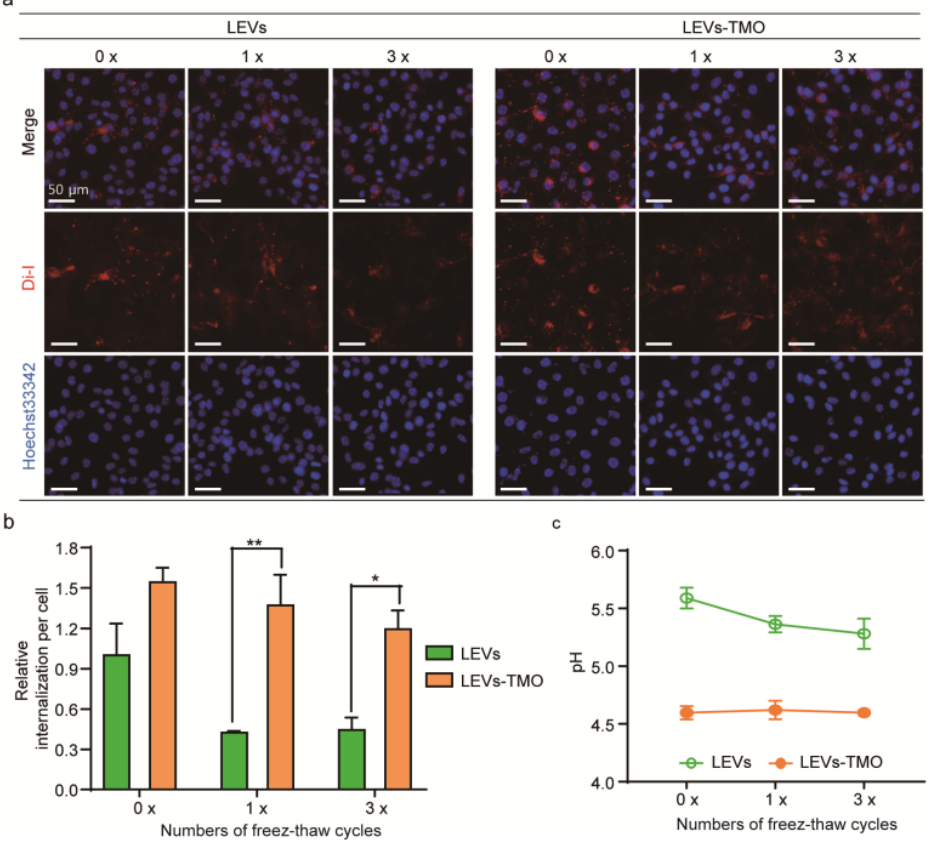
Figure 5. Comparison of cellular uptake for LEVs with and without preservatives. ( a ) Representative fluorescence microscopic images of cellular uptake over 3 h for fluorescently labeled LEVs and LEVs-TMO previously exposed to 0, 1, and 3 freeze-thaw cycles. ( b ) Summary data comparing intracellular fluorescence intensity per cell between LEVs and LEVs-TMO treated as described in ( a ). * p < 0.05, ** p < 0.01. ( c ) pH values for stored solutions of LEVs and LEVs-TMO exposed to 0, 1, and 3 freeze-thaw cycles.